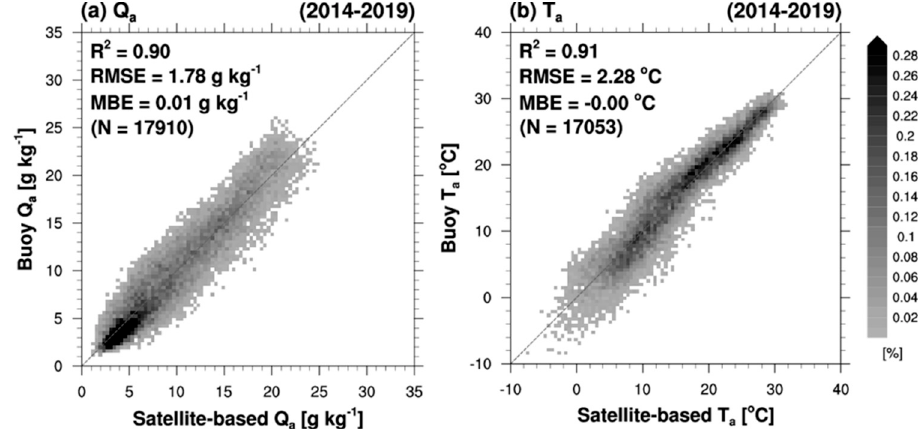
Figure 3. Comparison of daily mean ( a ) specific humidity (Q a ) and ( b ) air temperature (T a ) derived from satellite and buoy observations during the period 2014–2019. The dashed line is the 1:1 line. The color scale represents the density (%) of the data points. Remote Sens. 2021 , 13 , 42